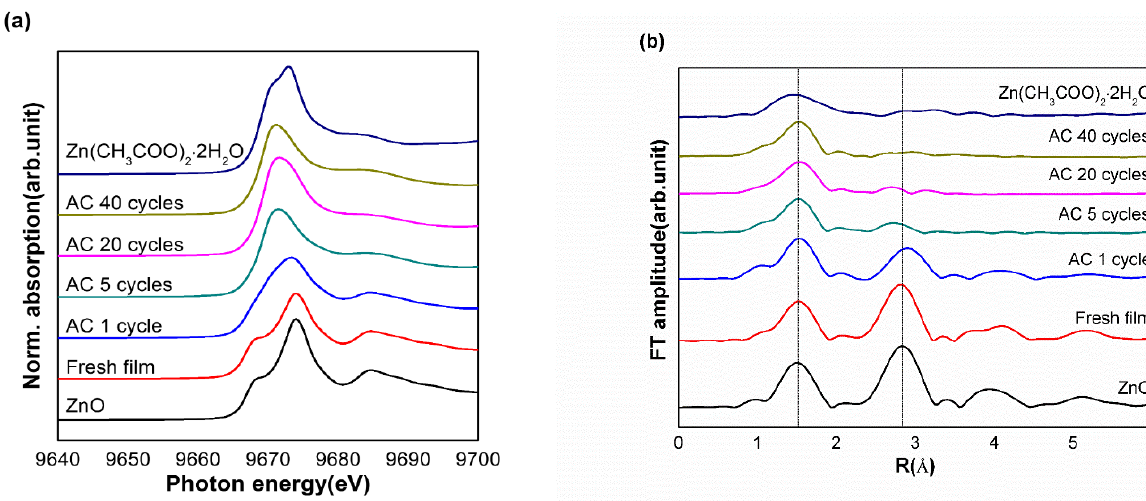
Figure 3. ( a ) XAS spectra of zinc acetate dihydrate and films treated with AC after different number of cycles. ( b ) FT-EXAFS spectra of zinc acetate dihydrate and films treated with AC after different number of cycles.